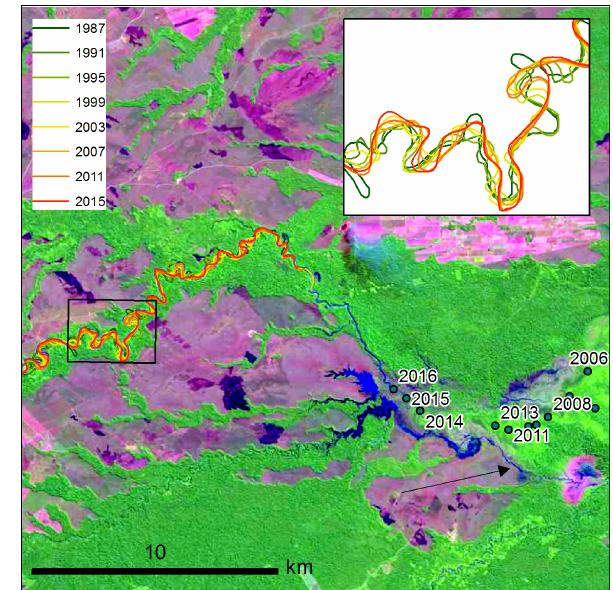
Figure 8. Evolution of the Cuberene River. The river flows from southwest to northeast. From 1995 to 2016, the location of the log- jams propagated upriver, along the two rivers that form the Cu- berene. By 2016, large areas that were forested in 1995 had been transformed into savannah. An east–west road crossing the Cu- berene in 1995 is completely obliterated in the 2016 image. Also notice how the light green areas in early stages of the successional process in 1995 are already forested by 2016.